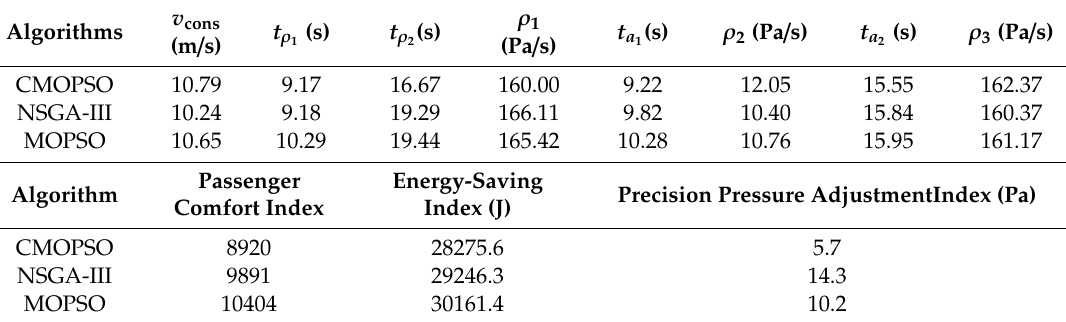
Table 5. Comparison results between the CMOPSO, NSGA-III, and MOPSO algorithms.